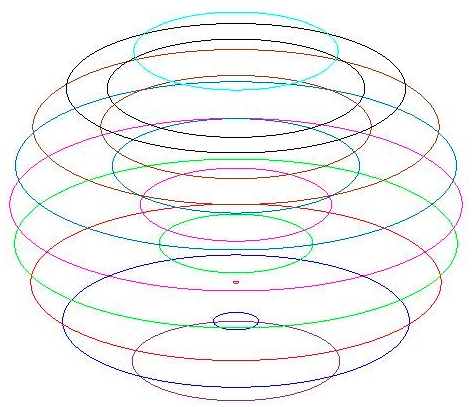
Figure 10. 3D workspace composed of boundary curves (nine layers).